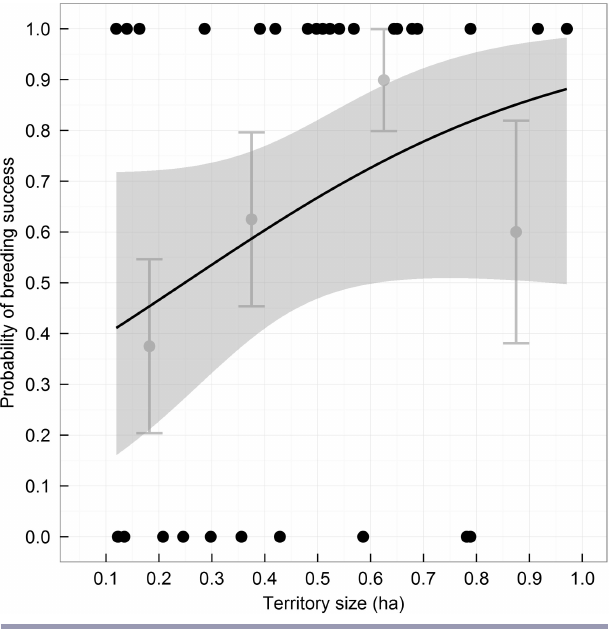
Fig. 5 . Plot illustrating the relationship between territory size and breeding success. The black trend line represents a smoothed loess line fit to the predicted values from the logistic regression of breeding success on territory size and the grey area represents the 95% confidence interval for the fitted line. Solid black circles represent breeding successes (value = 1) and failures (value = 0) with respect to associated territory sizes. Solid grey circles and error bars represent the proportion of successful nests and associated standard errors calculated from the raw data for territory sizes (ha; 50% KDE contour) binned in 0.25 ha